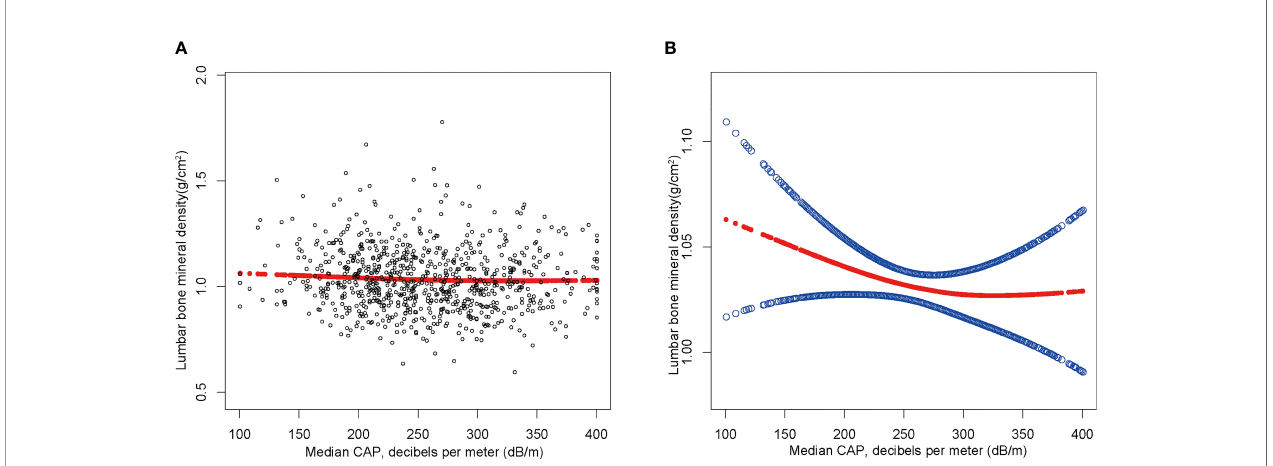
FIGURE 2 | The association between NAFLD and lumbar bone mineral density. (A) Each black point represents a sample. (B) The solid red line represents the smooth curve fi t between variables. Blue bands represent the 95% of con fi dence interval from the fi t. Age, gender, race, body mass index, poverty to income ratio,